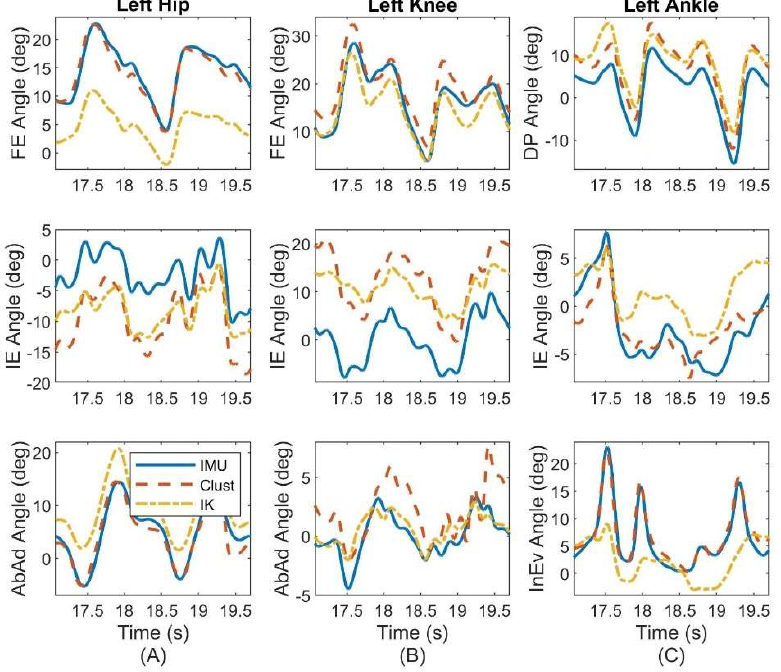
Figure A5. Lateral Left Walking. Example joint angle estimates over two stride cycles for lateral left treadmill walking. Plots show the three anatomical angles for ( A ) left hip, ( B ) left knee, and ( C ) left ankle. Estimates are also compared between ErKF (IMU), cluster (Clust), and inverse kinematics (IK) methods.